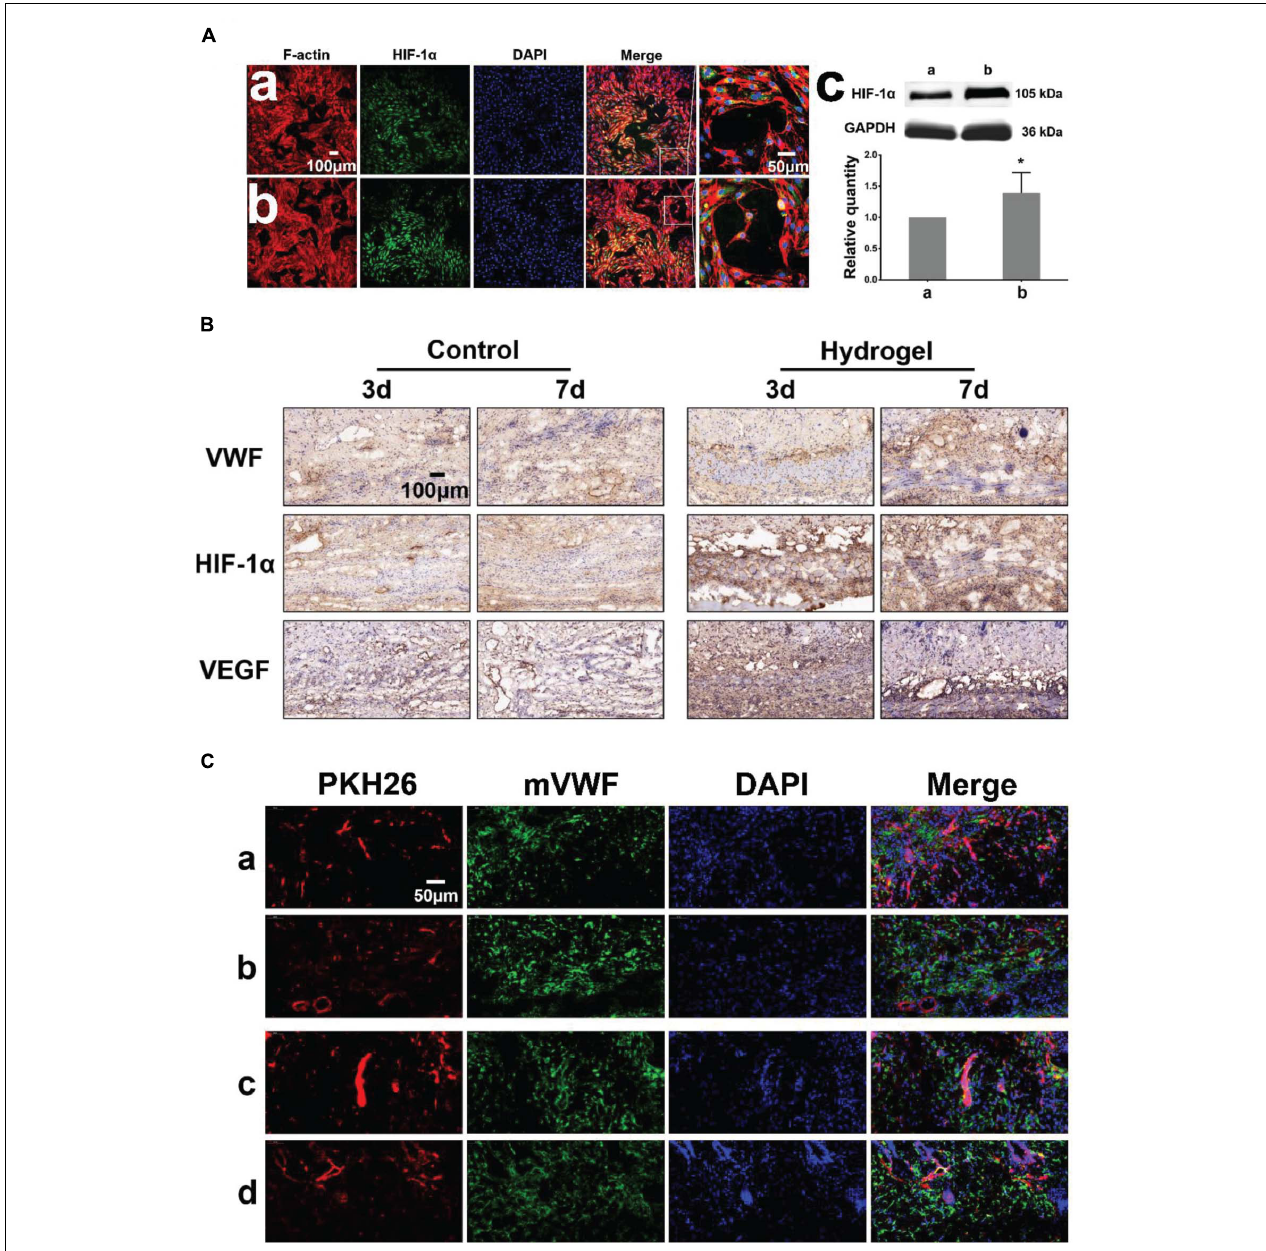
FIGURE 4 | Pro-angiogenic effect of hydrogels in vitro and vivo . (Aa,b) Immunofluorescence images of HDMECs implanted on blank confocal dishes and 2% β -cd hydrogel (HIF-1 α , F-actin). (c) Western blot analysis and quantification of HIF-1 α expression of HDMECs on the hydrogel. The expression of HIF-1 α in HDMECs on the 2% β -cd hydrogel was significantly higher than that in HDMECs on blank confocal dishes. (B) Immunohistochemical images of subcutaneously implanted hydrogels (VWF, HIF-1 α , VEGFA). The hydrogel group formed a neovascularization network at the initial stage of implantation and gradually matured, while the control group lagged behind. The hydrogel group showed high HIF-1 α and VEGFA expression in the new granulation area compared with the control group. (C) Immunofluorescence images of subcutaneously implanted hydrogels (PKH26, mVWF, DAPI). The HDMECs loaded in the hydrogel survived normally at the initial stage of implantation in mice and gradually formed new vessels with mouse tissue cells. [Label descriptions: (a) longitudinal section of 3 days, (b) cross section of 3 days, (c) longitudinal section of 7 days, (d) cross section of 7 days]. (* P < 0.05 was considered statistically significant).